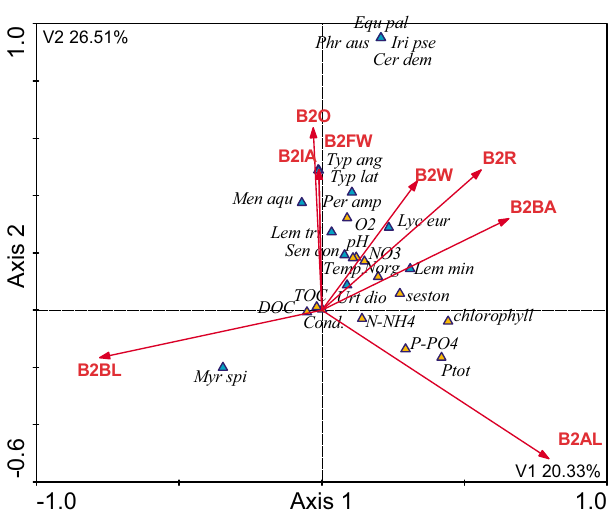
Figure 4. CCA model of dependencies between plant species, the physicochemical variables and land use types in the 200 m buffer zone [Explanations—see Fig.